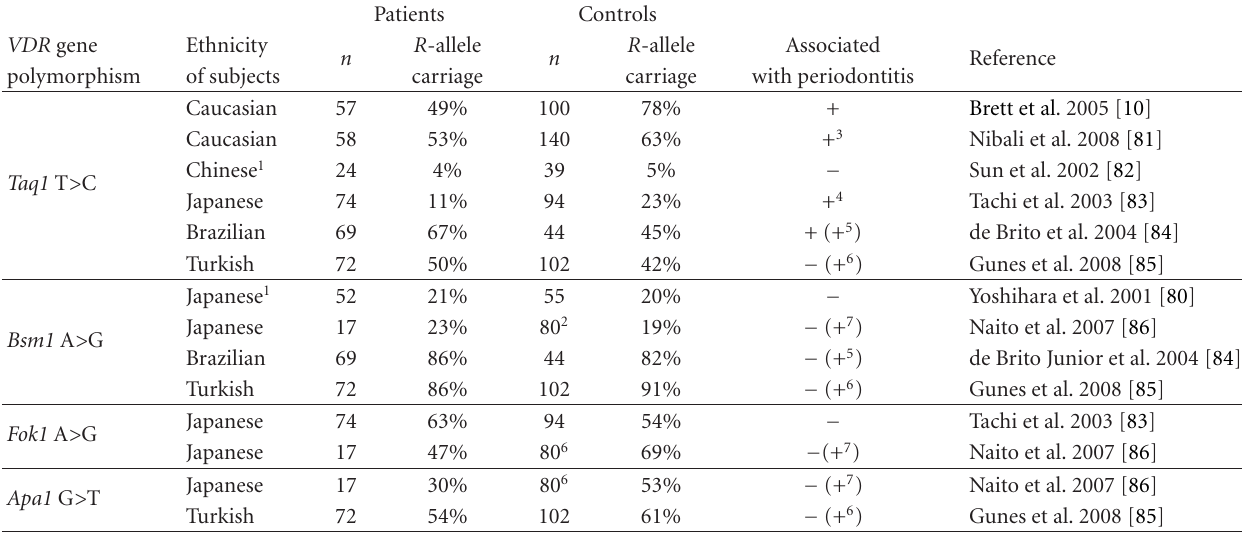
Table 10: The vitamin D receptor ( VDR ) gene polymorphisms and carriage rate of the Rare ( R )-allele in case-control studies and association with susceptibility to chronic